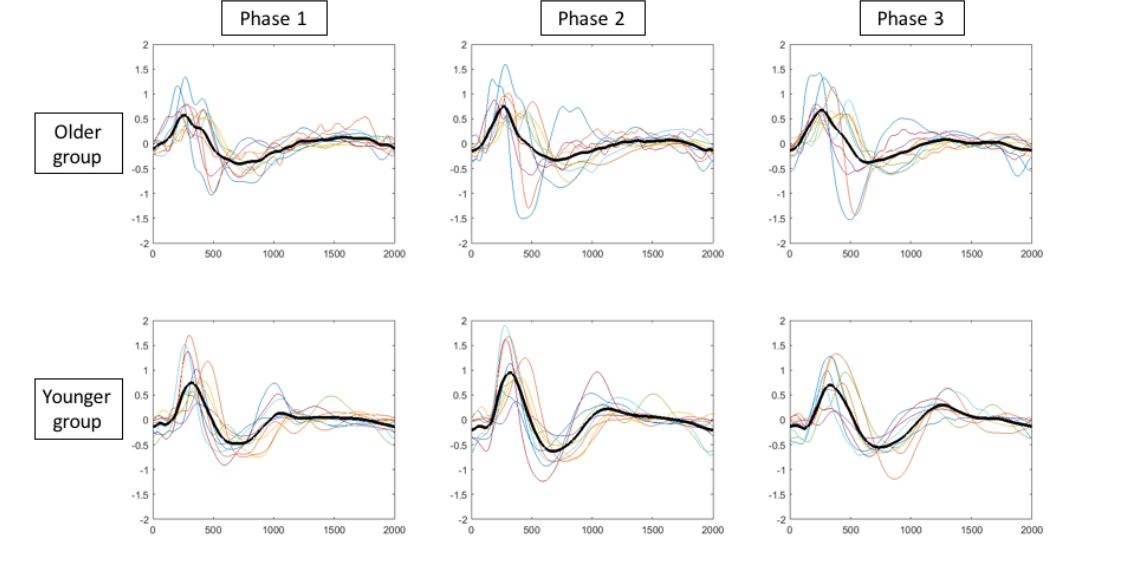
Fig. 3. The ensemble averages of –dZ/dt for each individual within each phase (colored lines). The mean of these curves is shown in the thick black lines (grand ensemble averages).